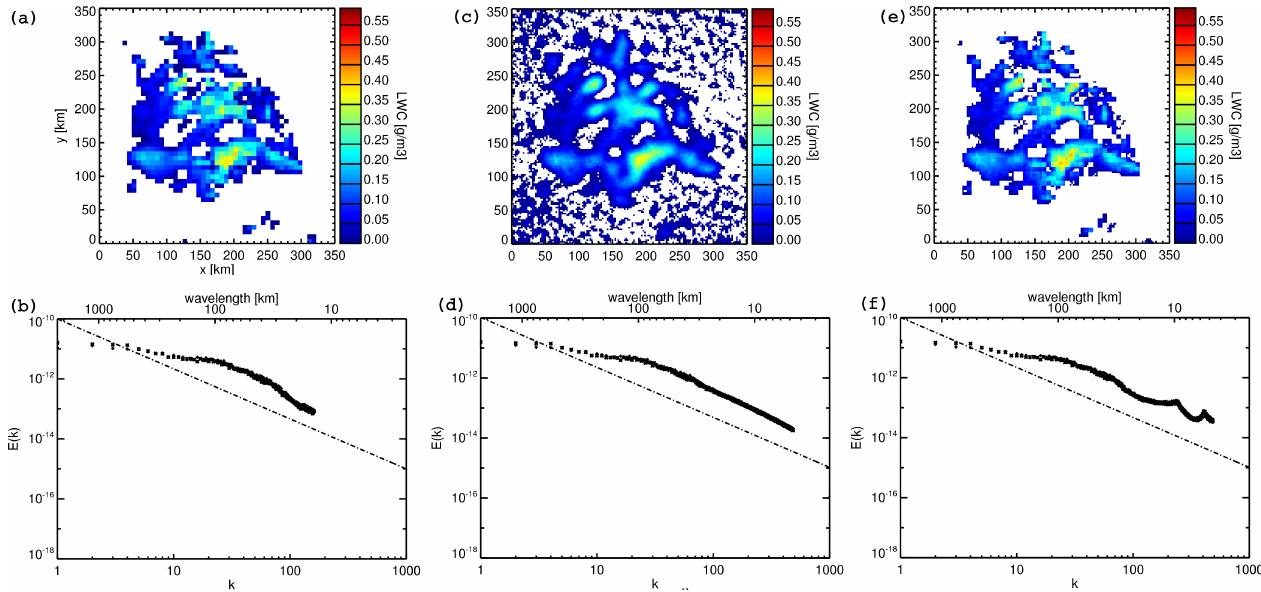
Fig. 1. Downscaling of a layer of LWC from the COSMO-EU model: Shown is a water content field of a certain height level from COSMO- EU (a) through the iteration steps (c) leading to the final downscaled field (e) . Through the process negative LWC values are allowed (reflected by the spurious positive water content values in dark blue throughout the cloud free areas in (c) ). All these values are set to zero in (e) . (b) , (d) , and (f) show the related power